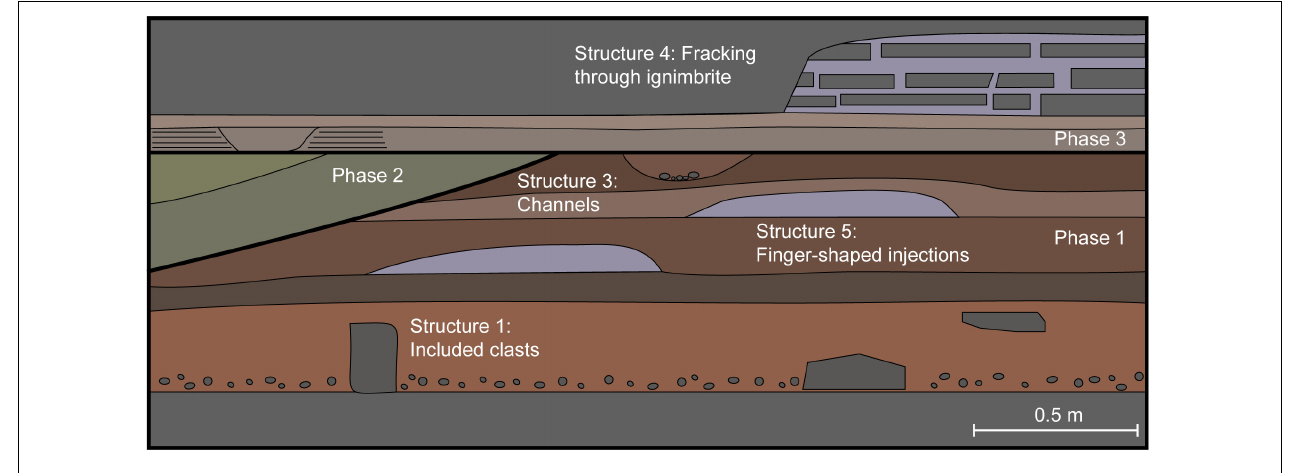
FIGURE 12 | Schematic showing the different phases and structures in the tuffisite fill. Phase 1: A laterally extensive fining upwards sequence is deposited, containing large ignimbrite clasts (Structure 1) separated from the country rock. Phase 2: Fining upwards sequences are deposited unconformably above Phase 1, in more localised units, to form structures such as channels (Structure 3) and cross-lamination. Phase 3: Laterally extensive tuffs and lapilli-tuffs are deposited at the top of the tuffisite. As fluid pressure increases material fractures off blocks of ignimbrite from the tuffisite roof (Structure 4) and forms finger-shaped injections at the tuffisite centre (Structure